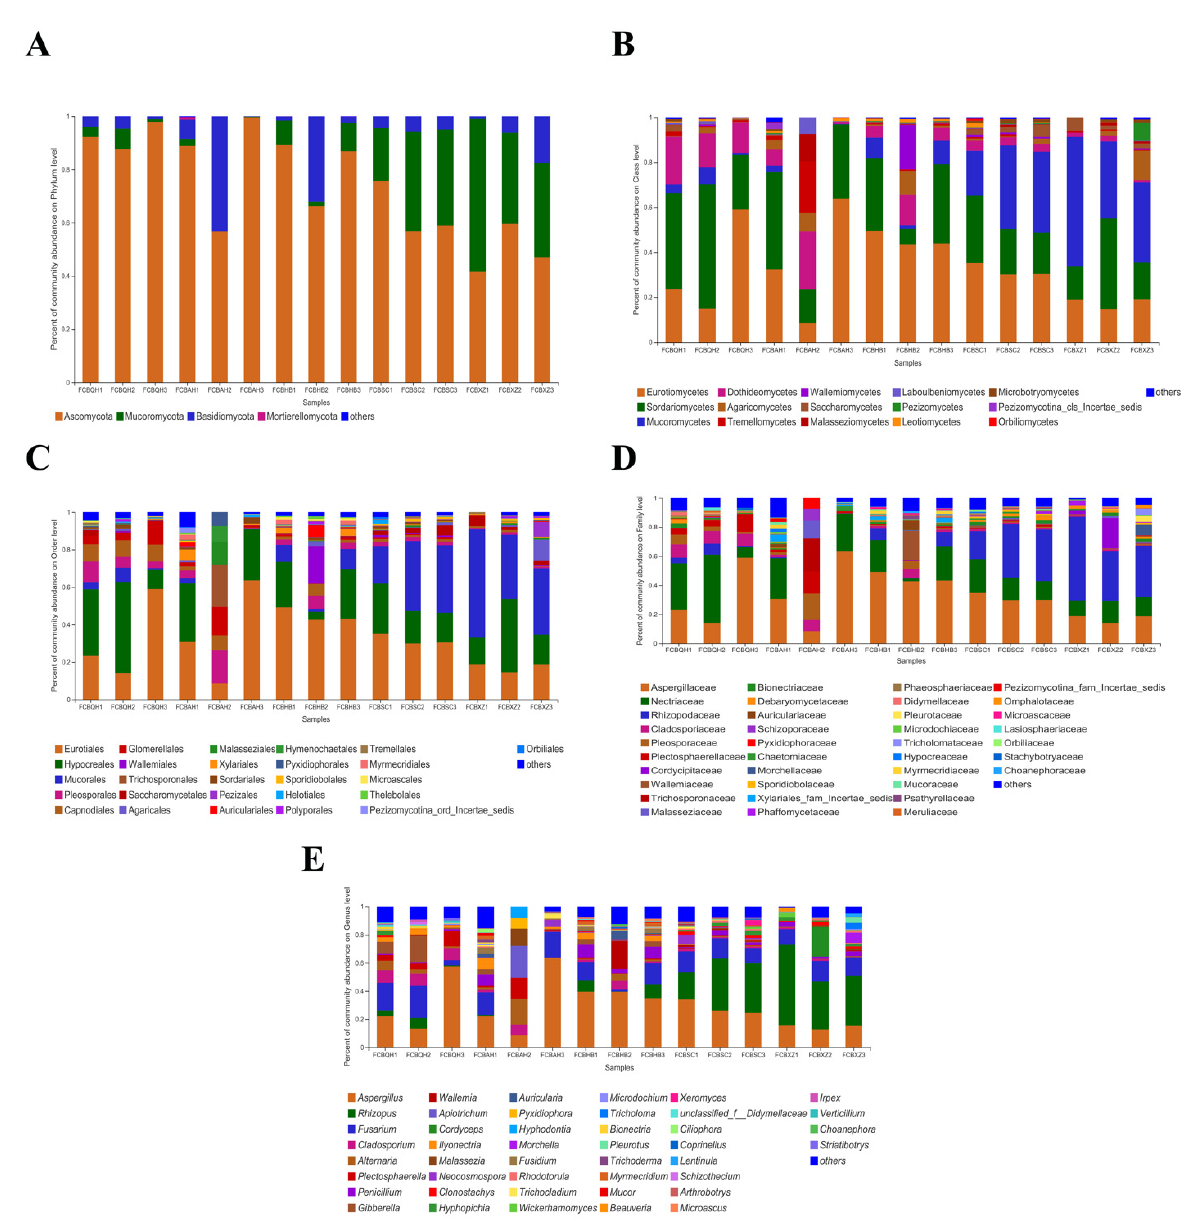
Figure 1. Fungal community composition in 15 FCB samples at the ( A ) phylum level; ( B ) class level; ( C ) order level; ( D ) family level; and ( E ) genus level. Genera, whose relative abundances were over 1% in at least one sample, were displayed, and others represent the sum total of other genera whose relative abundances were less that 1%.